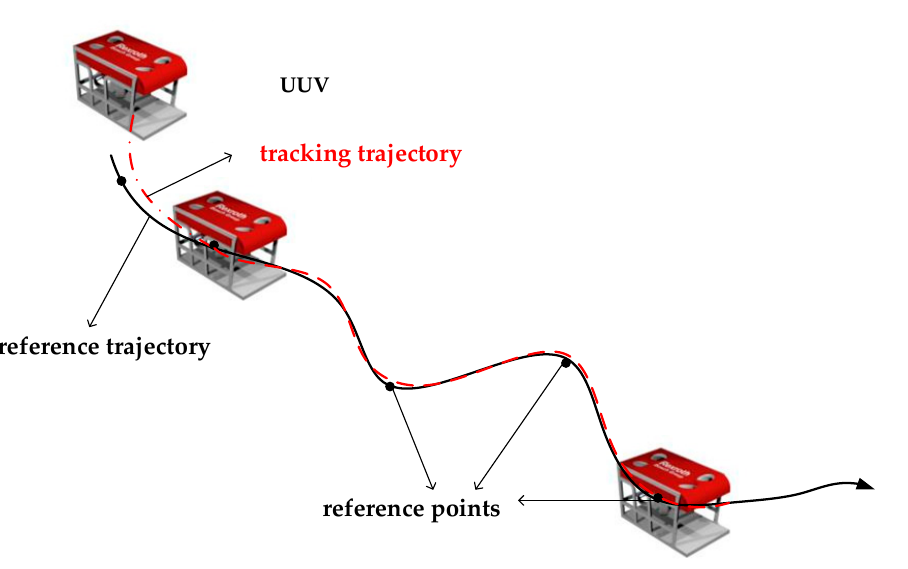
Figure 2. Schematic diagram of the trajectory tracking process of UUV.